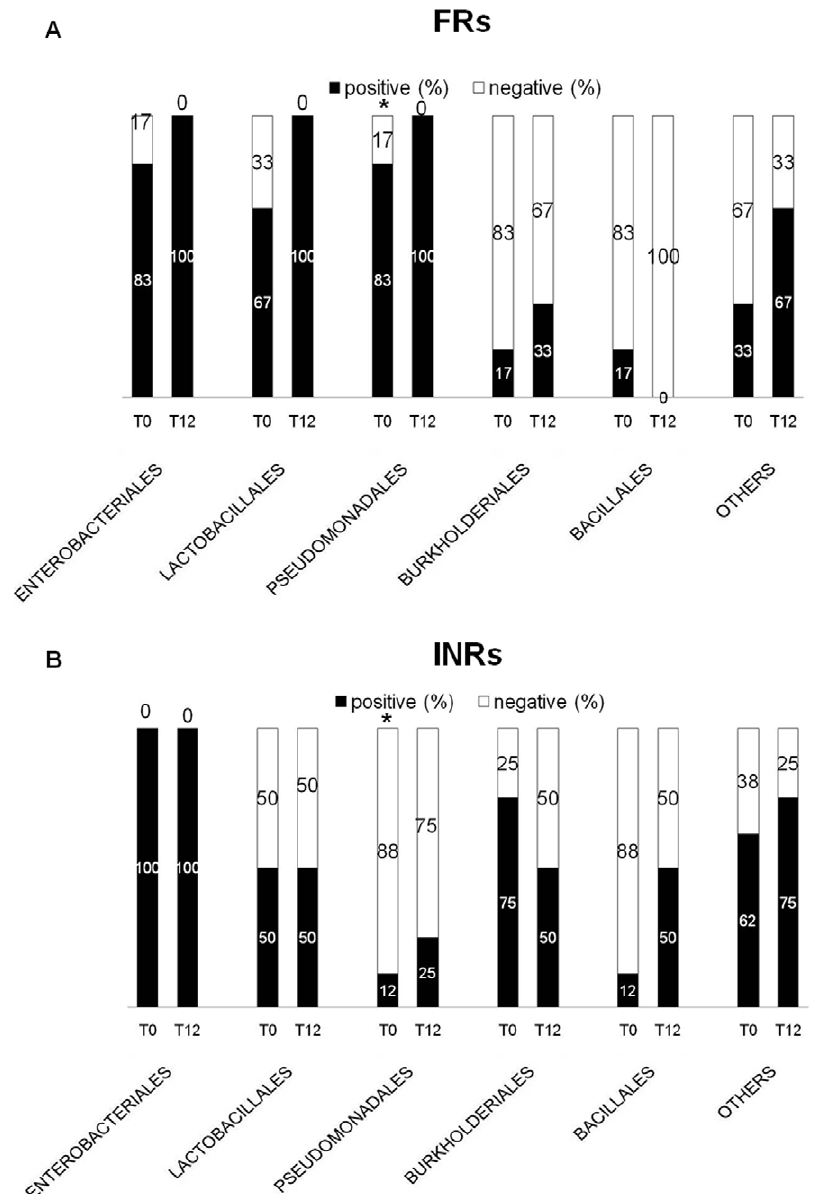
Figure 2. Characterization of translocating microflora in PIRs and INRs. Bacterial microflora translocating in peripheral blood was evaluated in 44 HAART-naive patients with severe immune depression (CD4 + # 200/ m L) at baseline and after 12 months of stable HAART (T12). At T12, 29 patients were partial immunological responders -PIRs- (CD4 + $ 250/ m L; VL , 60 cp/mL) and 15 were immunological-non-responders -INRs- (CD4 + , 200/ m L; VL , 60 cp/mL). At baseline, we found a significantly higher proportion of PCR-positive INRs (INRs: 8/15, 53%; PIRs: 6/29, 20%; p=.04). At T12 a non significantly higher proportion of INRs yielded a positive 16S gene PCR amplification: INRs: 4/15 (27%); PIRs: 3/29 (10%); p=.21. PIRs and INRs displaying a similar bacterial orders both at baseline and T12, except Pseudomonadales order *(FRs 5/6, 83% vs 1/8, 12% p=.026). Positive (%)= # patients displaying a specific bacterial order/total # of PCR positive PIRs (or INRs). Negative (%)= # patients negative for a specific bacterial order/total # of PCR positive PIRs (or